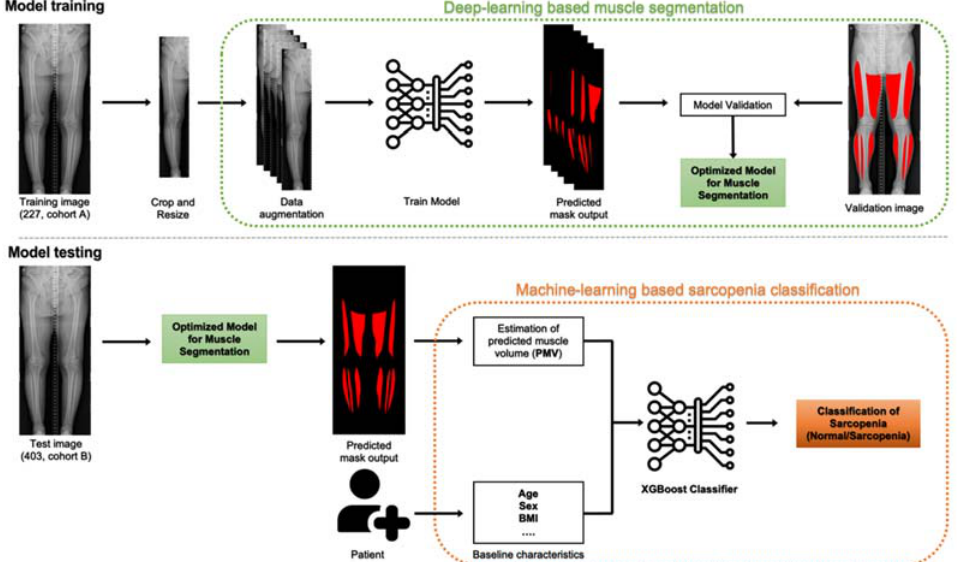
Figure 2. Model overview. Model training, left to right: the model is trained on input images, which undergo preprocessing (crop and resize) and augmentation (enriching the training set) before being fed into the convolutional neural network. The model is trained and validated by 5-fold cross validation. Hyperparameter tuning is conducted to optimise the model for muscle segmentation. Model testing, left to right: the optimised eXtreme Gradient Boosting (XGBoost) classification model is used to estimate predicted muscle volume (PMV) of the patients and, along with baseline characteristics, to classify patients into sarcopenia and normal groups.